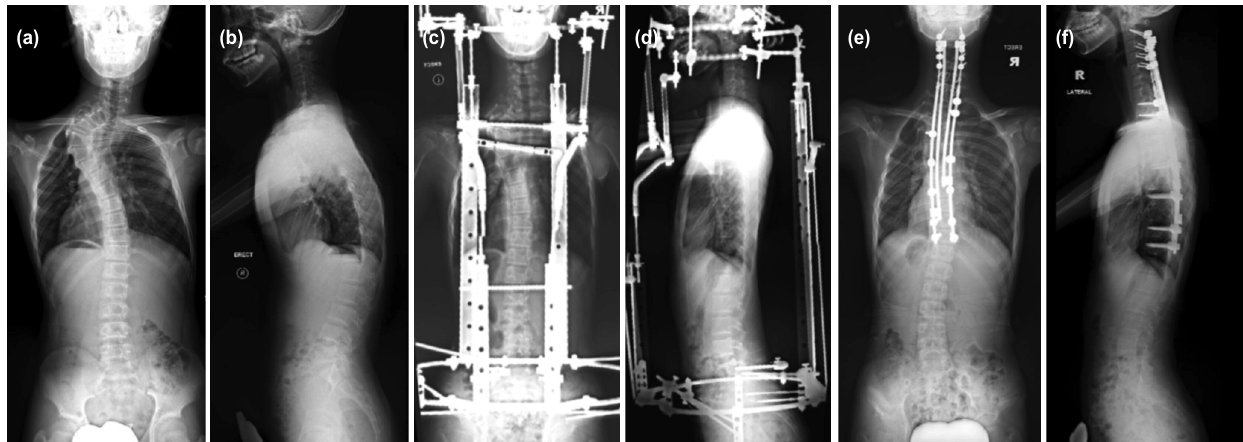
Plain radiographs (posteroanterior and lateral view) of Case 2: (a, b) before operation, (c, d) while on halo-pelvic traction, and Fig. 2: (e, f) after single-stage posterior spinal fusion.